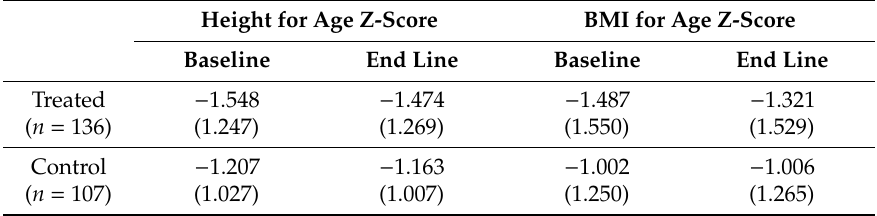
Figure 4. Iron and zinc content in the millet-based meals in comparison with a fortified rice-based meal. Table 7. Undernutrition indicators for the sampled children at baseline and end line by treatment